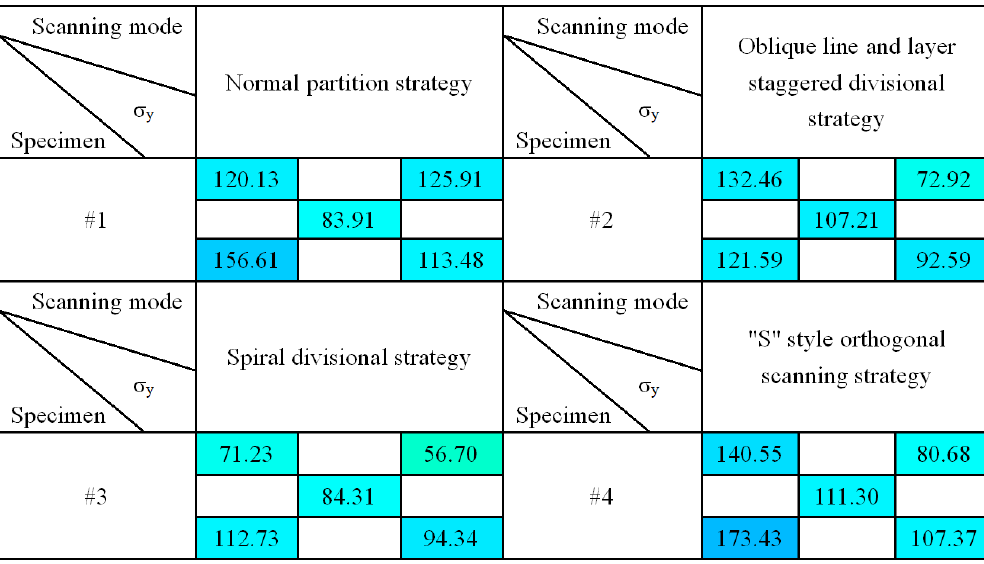
Figure 12. The result of Y- direction residual stress σ y .